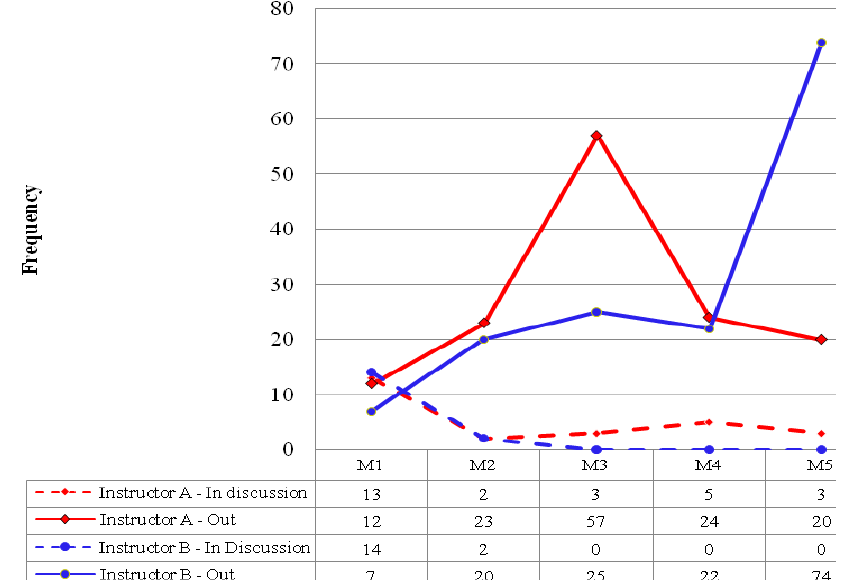
Figure 1 . Teaching presence in and out of threaded discussions. 2. How do instructors employ communicative functionality within the course to demonstrate teaching